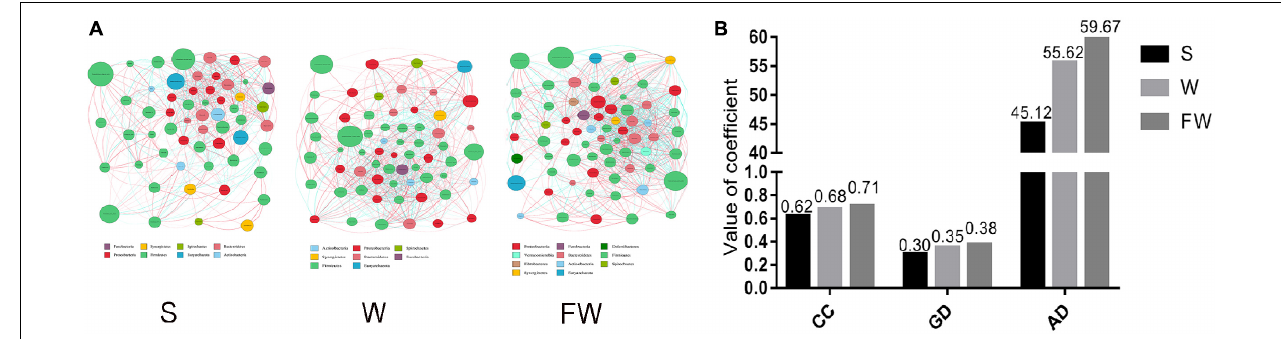
FIGURE 11 | Network analysis of microbial community. (A) Microbial co-occurrence network analysis in three groups based on the calculation of Spearman’s correlation coefficients. The nodes represented different genus and their size represented the average relative abundance of the genus. The thickness of the connection between the nodes is positively correlated with the absolute value of the correlation coefficient of species interaction. The red lines indicated positive correlations and blue lines indicated negative correlations. (B) Typical coefficients derived from network analysis in three groups. CC, Clustering coefficient; GD, graph density; AD, Average degree (S, Sucking; W, Weaned; FW,